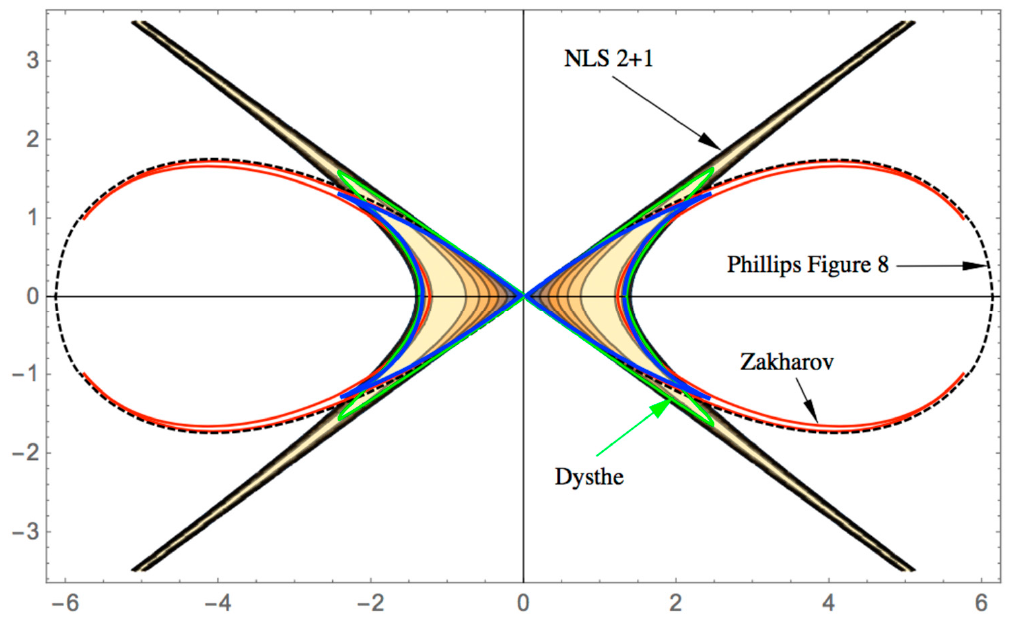
Figure 5. The wavenumber domain with the boundaries of the modulational dispersion relation for several nonlinear wave equations. The 2 + 1 NLS equation boundary is shown by two crossed black lines and associated hyperbolae. The boundary of the Dysthe equation is shown in green and the boundary of the Trulsen–Dysthe equation is shown in blue. The Zakharov equation boundary is shown in red and the Phillips figure eight is represented as a dotted line. For ocean waves, the central lines cross at the peak of the directional spectrum. The horizontal wavenumber coordinate lies along the dominant direction of the wave motion and the peak has been shifted to zero as seen on the horizontal axis. Additional information about coordinate definitions is shown in Figure 4.